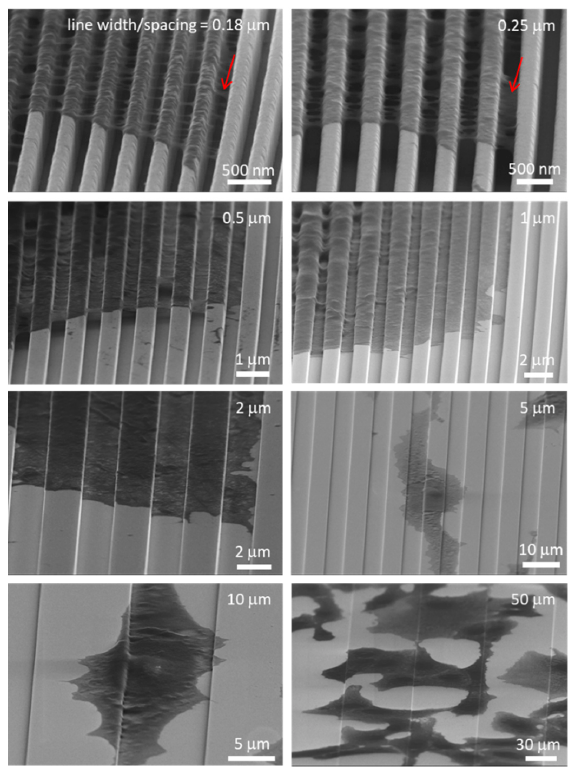
Figure 6. SEM micrographs 70 ◦ tilted of cells on comb structures with line widths of 0.18–50 µ m. Two distinct types of cell adhesion morphologies are observed: Type 1—Adherent cells on 0.18 µ m and 0.25 µ m structures only contacted the top portion of lines but did not fill the trench gaps, and Type 2—Cells on comb structures with line widths larger than 1 µ m exhibit conformal surface coverages. Both morphology types were observed for adherent cells on the 0.5 µ m comb structures. All cells were incubated on the structures for 24